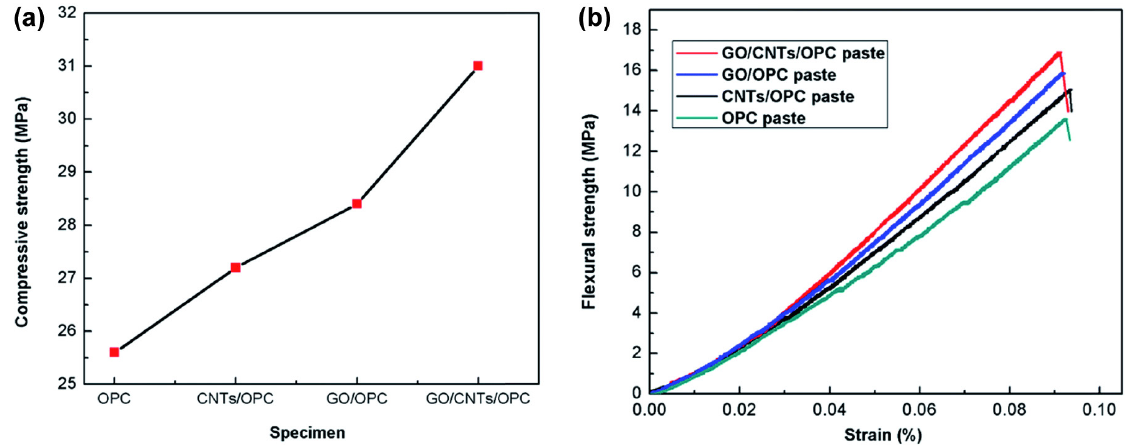
Figure 10: (a) Compressive strength; (b) flexural strength of cement-based composites containing CNTs (CNTs/OPC), GO (GO/OPC) and a GO-CNT hybrid (GO/CNTs/OPC) [119]